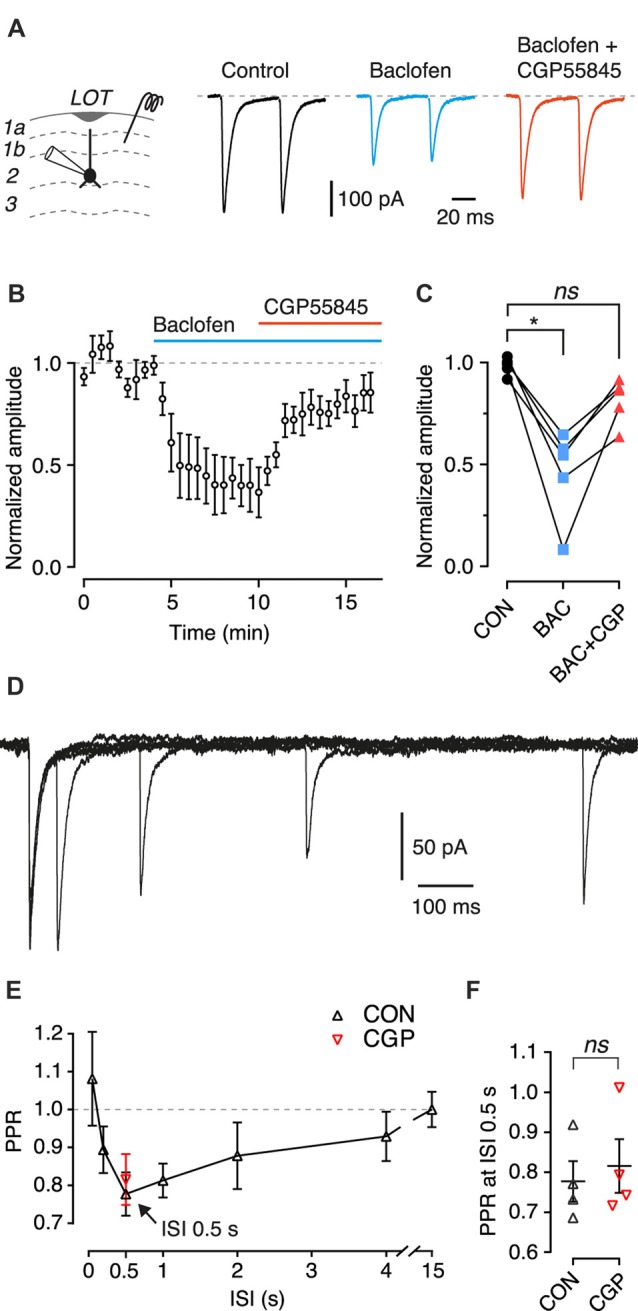
Activation of presynaptic GABAB heteroreceptors inhibits EPSCs from associational inputs onto SP cells, but these receptors are not involved in paired-pulse depression. (A) Typical EPSCs recorded in an SP cell in response to paired-pulse stimulation (50 ms interstimulus interval, ISI) of layer 1b during control (black), in the presence of baclofen (100 μM; blue) and baclofen + CGP55845 (5 μM; red). Each trace is an average of 10 episodes. Stimulus artifacts have been blanked. (B) Mean EPSC amplitude, normalized to the mean amplitude during the control period, plotted vs. time. Baclofen (bath applied during the period shown by the blue bar) decreased the normalized EPSC amplitude, and addition of CGP55845 (application shown by the red bar) reversed this inhibition. Error bars are ± SEM. Data from n = 5 SP cells. (C) Summary data for (B) showing the normalized EPSC amplitude averaged over the control period (CON, 100–190 s), the period in baclofen (BAC, 400–490 s) and the period in baclofen + CGP55845 (BAC+CGP, 800–890 s). Symbols show means for individual cells (n = 5 SP cells). (D) Typical data from an EPSC paired-pulse experiment with an SP cell and ISI 50, 200, 500 and 1000 ms. Each trace is an average of five episodes. Stimulus artifacts have been blanked. (E) Mean paired-pulse ratio (PPR) plotted vs. ISI (n = 4 SP cells). Arrow indicates the ISI with the smallest PPR (0.5 s). Black symbols show the mean PPR measured under control conditions; red symbol shows the mean PPR measured at 0.5 s ISI in the same cells in the presence of 5 μM CGP55845 (n = 4 SP cells). Error bars show ± SEM. (F) Summary data for (E) showing PPR at 0.5 s ISI during control (CON) and in the presence of CGP55845 (CGP). Symbols show the mean for individual cells (n = 4 SP cells). Error bars show ± SEM. ns, not significant; *p < 0.05.